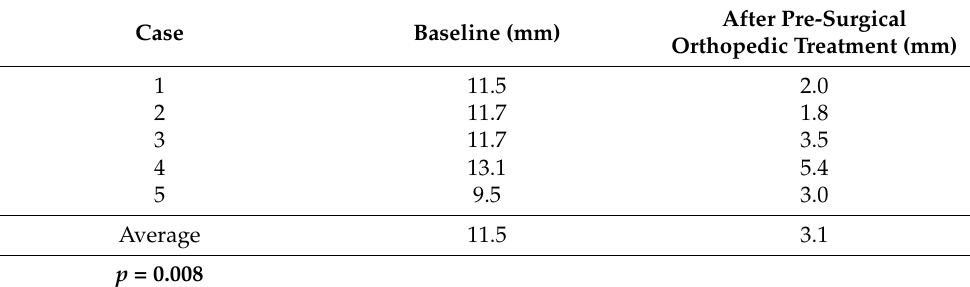
Table 4. Comparison of the baseline cleft jaw width on the model and after pre-surgical orthopedic